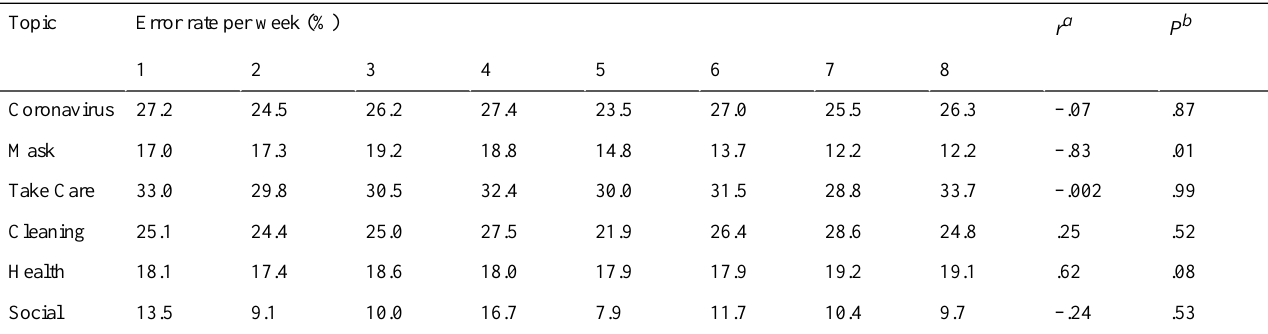
The error rates were grouped by topic and analyzed weekly (Table 1). A negative trend was observed only for the topic Table 1. Error rates by topic per week (July 20 to September 13, 2020).